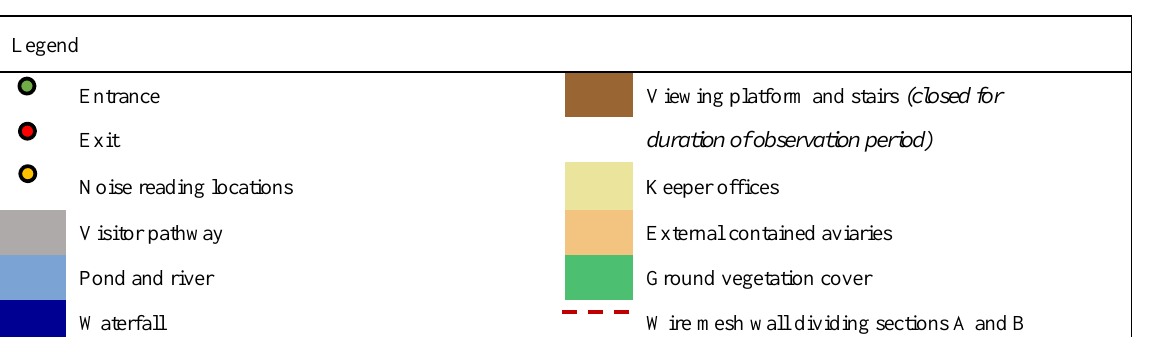
Figure 1. An overhead map of the Main Free-flight Aviary at Zoo Tampa at Lowry Park, Tampa FL, used for data collection, analysis and